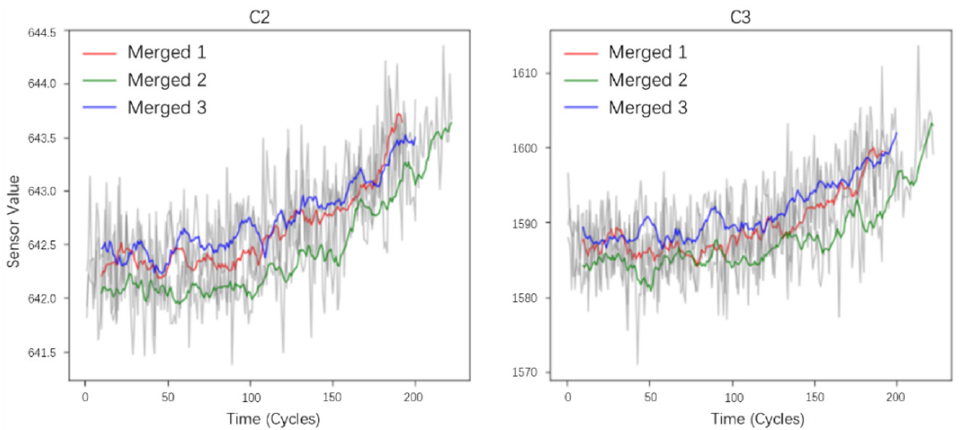
Figure 12. Visualization of the reconstructed FD002.